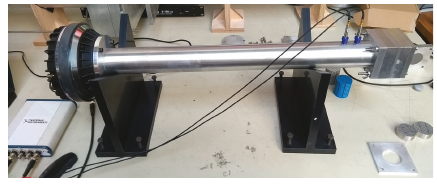
Figure 8: Impedance tube